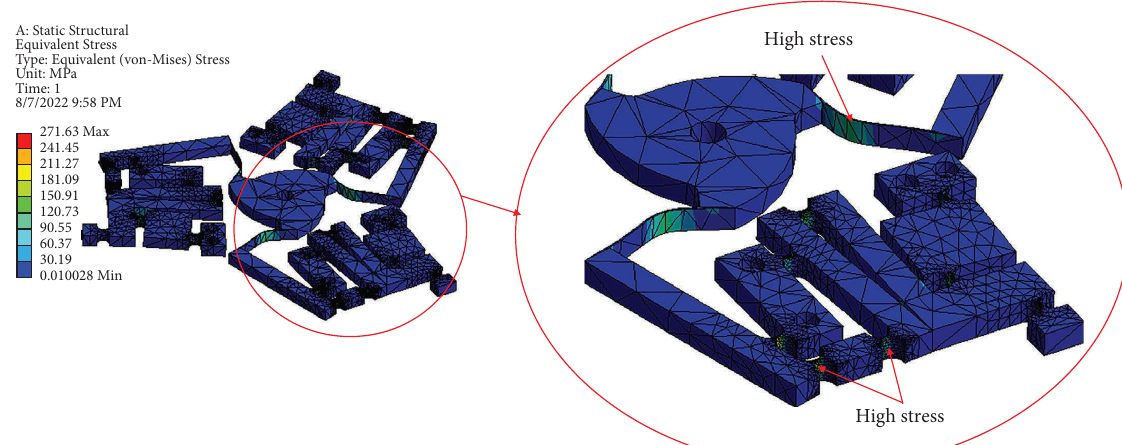
Figure 7: Stress